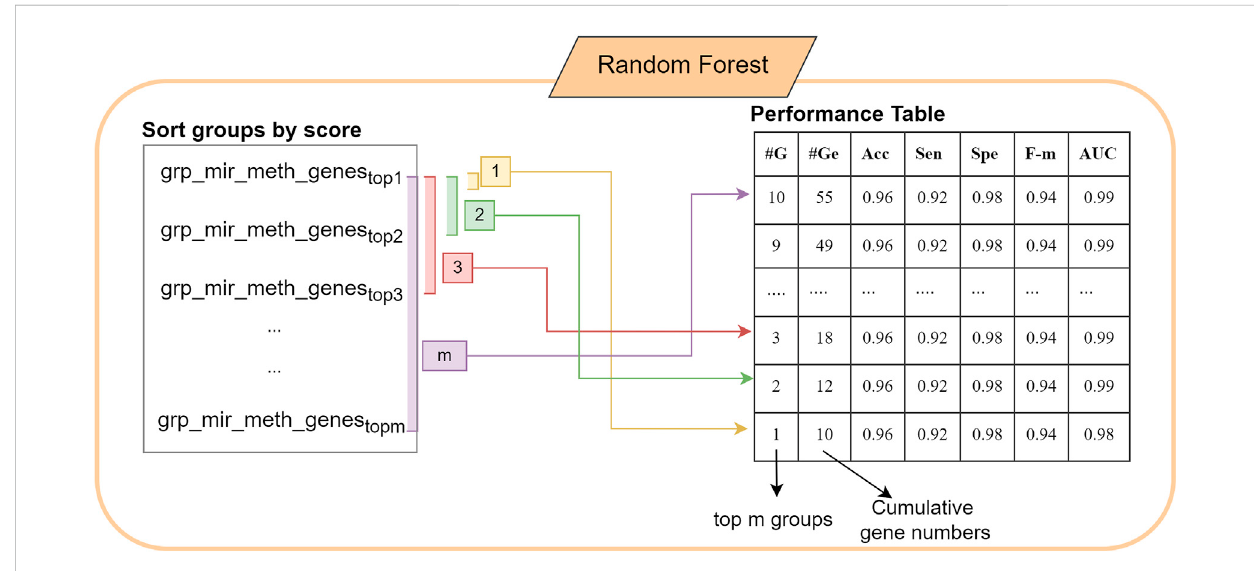
FIGURE 2 The construction of the performance table in 3Mint using the most signi fi cant